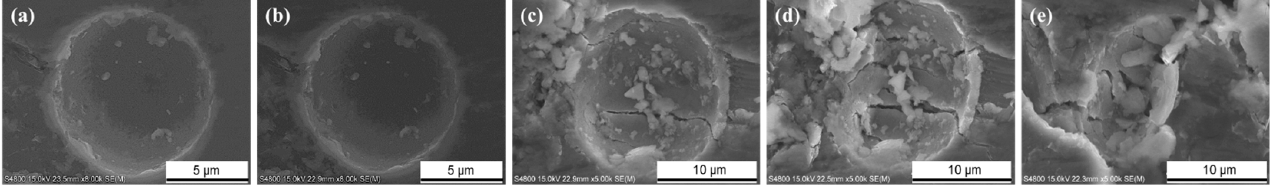
Figure 13. GHS fracture behavior of Al60G10 foam under compressive strain: ( a ) 1% strain. ( b ) 4% strain. ( c ) 8% strain. ( d ) 12% strain. ( e ) 15% strain.